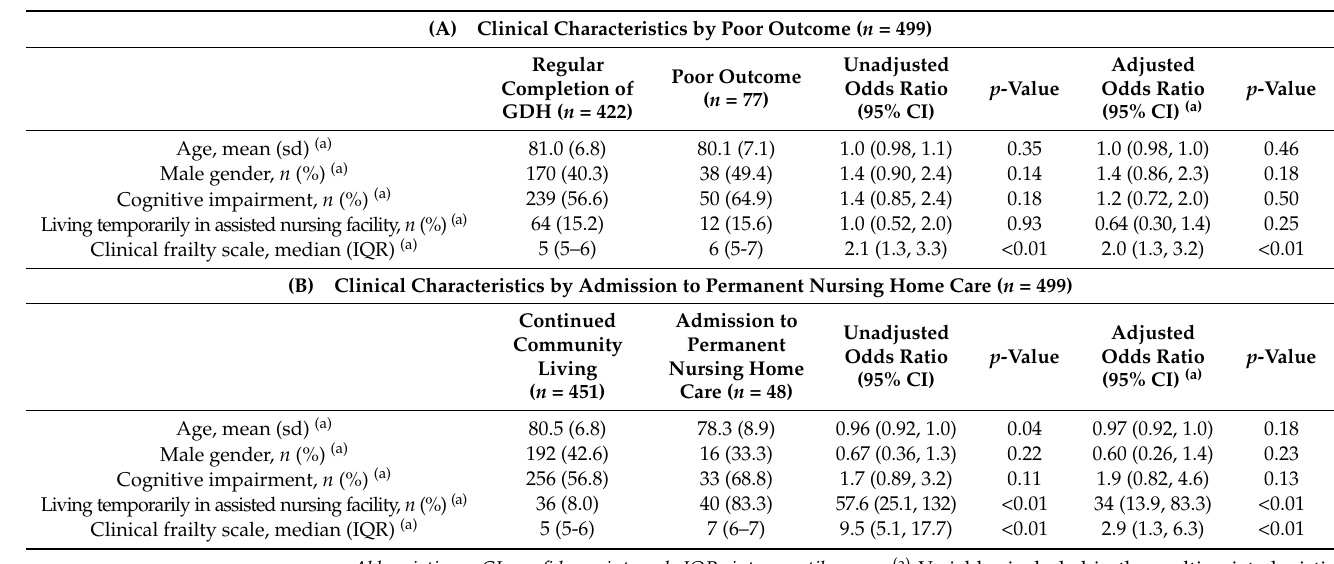
Table 2. ( A ) Clinical characteristics by poor outcome ( n = 499). ( B ) Clinical characteristics